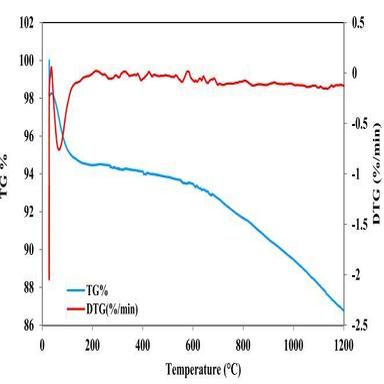
Thermal analysis of the as-freeze-dried sample; TG % and DTG.